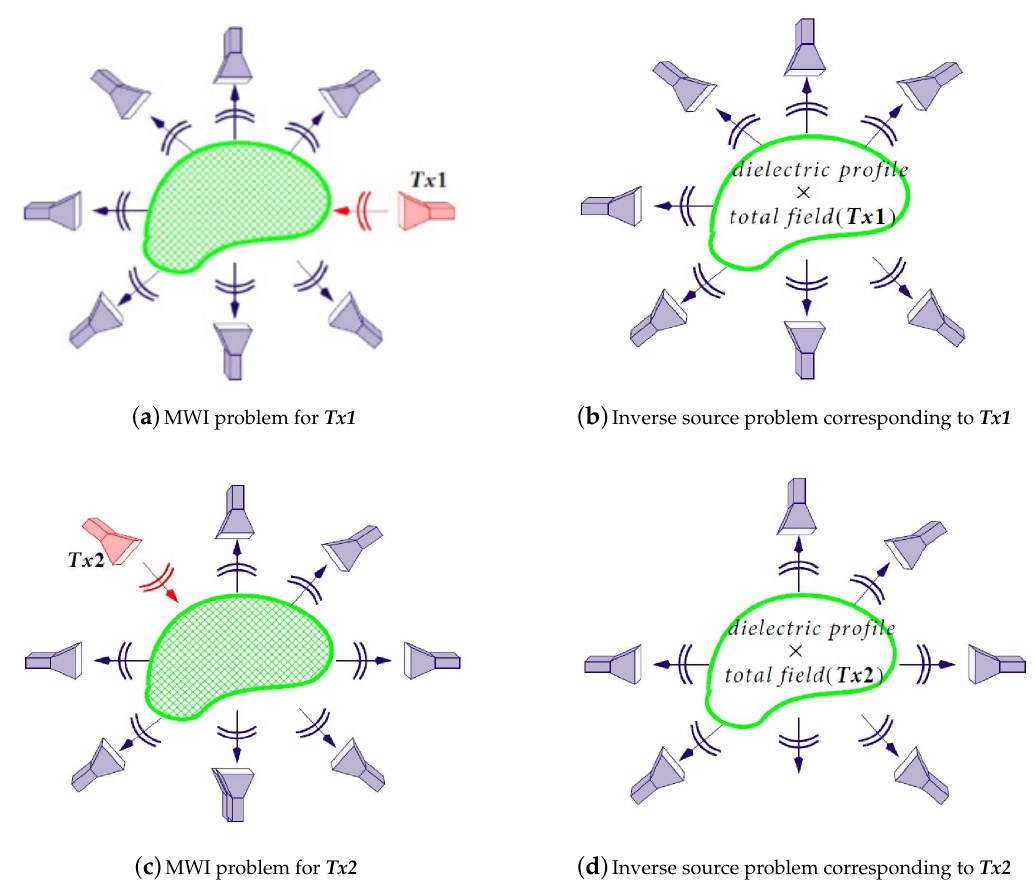
Figure 1. Demonstration of the relation between the MWI and inverse source problems. ( a ) represents the MWI problem when the OI is interrogated by the transmitter Tx1 (red antenna) while the other antennas (grey antennas) act as receivers; ( b ) represents the equivalent inverse source problem for ( a ) in which Tx1 has been replaced by contrast sources in the geometrical domain of the OI; similarly ( c , d ) demonstrate the same concept but for a different transmitter: Tx2